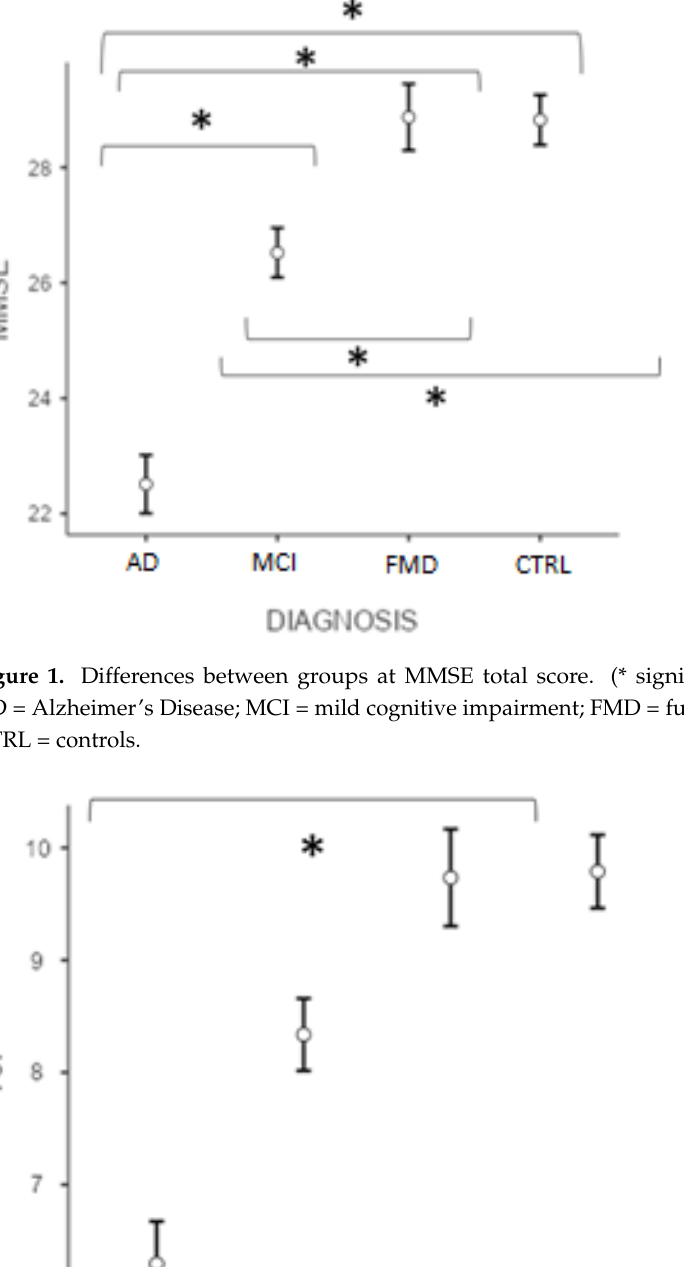
Figure 2. Differences between groups at T5P total score. (* significant different, p < 0.001). AD = Alzheimer’s Disease; MCI = mild cognitive impairment; FMD = functional memory disorders; CTRL = controls.